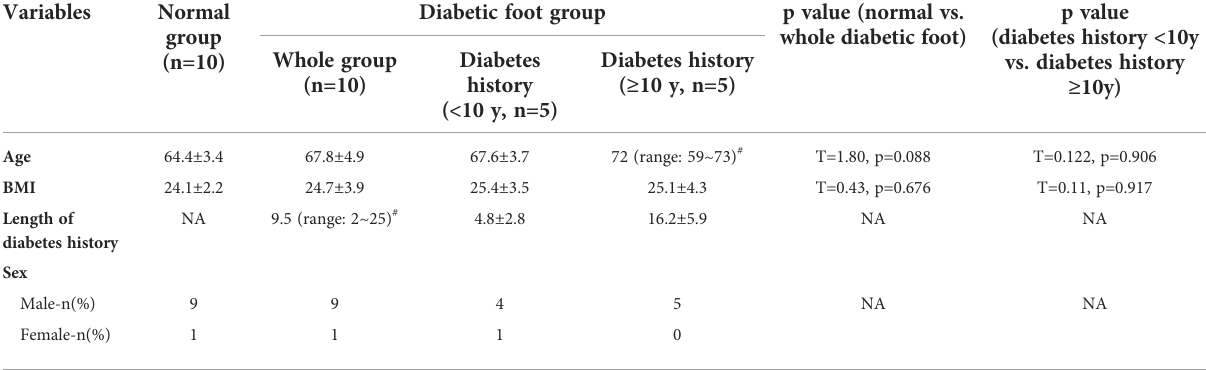
TABLE 1 Baseline characteristics of the enrolled